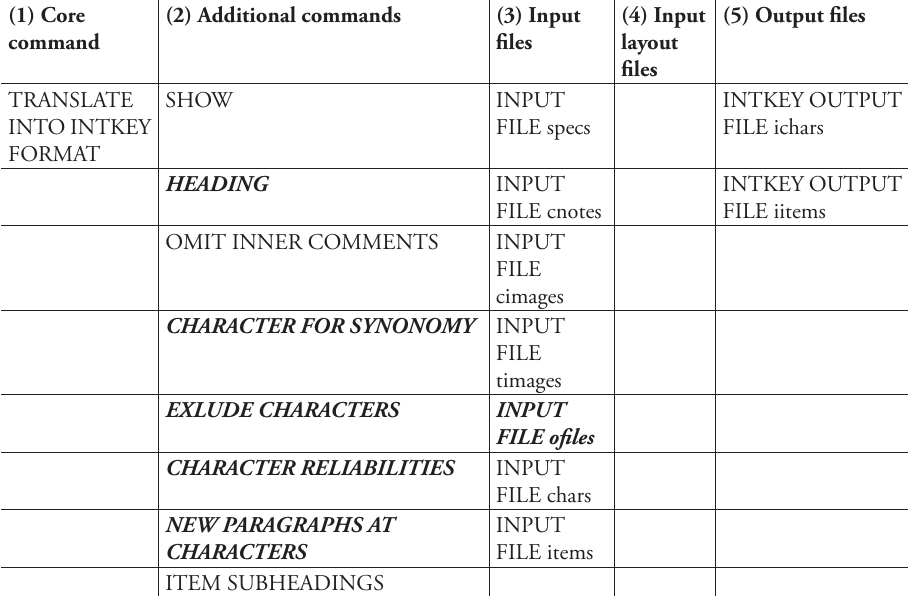
Table 3. Classifi cation of commands used in the toint directive fi le. Reference numbers used in Fig. 30 are given in the header of the table. Th e commands in bold and italics may require changes being made by the